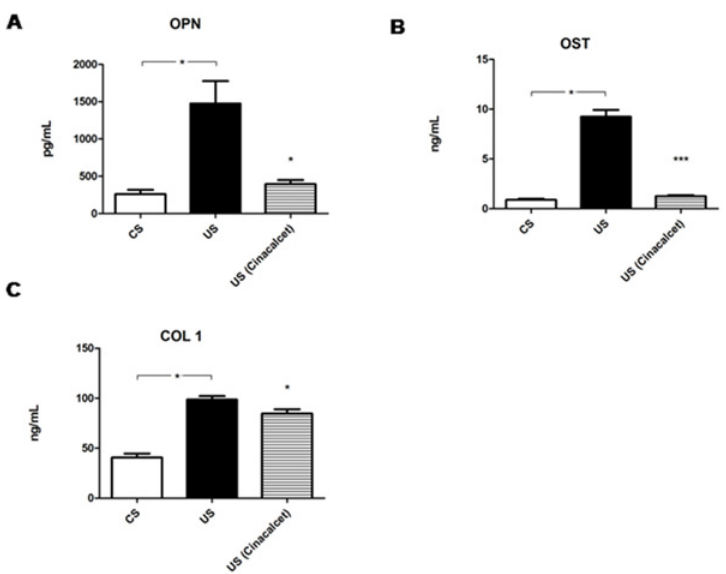
Figure 6. Levels of osteopontin, osteocalcin and collagen type I, in response to uremic serum from patients under cinacalcet treatment. Osteopontin (OPN, panel A), osteocalcin (OST, panel B) and collagen type I (COL1, panel C) during hMSC differentiation in the presence of serum from hemodialysis patients treated with cinacalcet (US cinacalcet), compared to serum from non-treated patients (uremic serum, US). Results from control serum (CS) were added for comparison. * p < 0.05, *** p < 0.001.